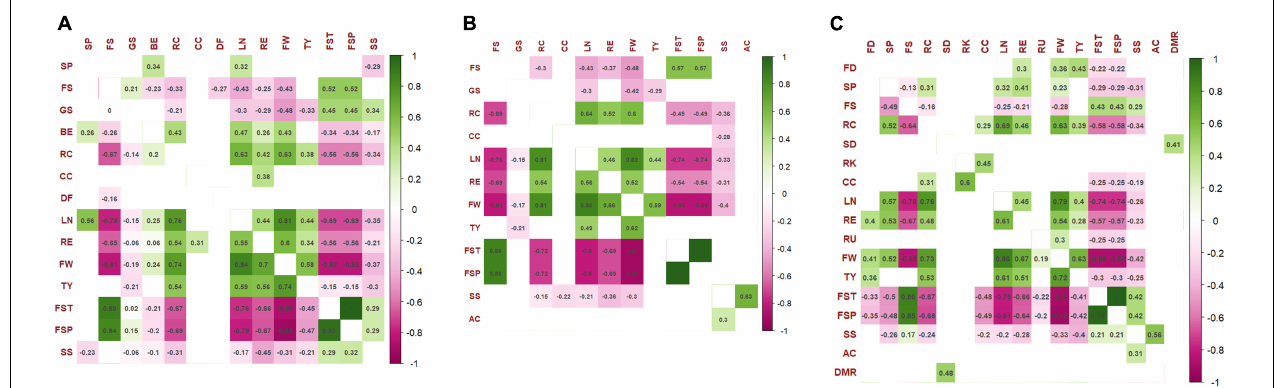
FIGURE 7 | The Spearman’s rank significant correlations between pairs of traits evaluated in 42 tomato accessions. (A) Control, (B) nitrogen stress, and (C) water stress. Correlation coefficients are indicated in each cell. Colored cells are those with p -value < 0.01. Color intensity is directly proportional to the coefficients. According to the scale on the right, green and purple colors correspond to positive and negative correlations, respectively. Correlations among traits in IT are shown below the diagonal; correlations in SP are above the diagonal. The full name of each trait abbreviation can be found in Table 2